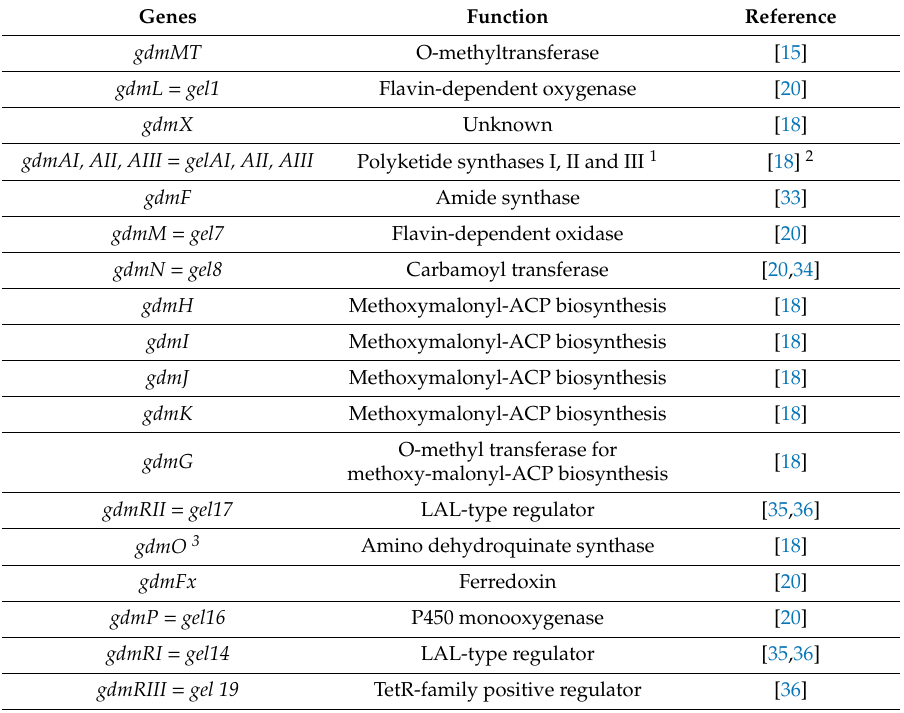
Figure 2. Cluster of geldanamycin genes in S. hygroscopicus NRRL3602. Cluster of geldanamycin genes in S. hygroscopicus NRRL3602 [18]. The name of each gene is indicated above it. Similar gene clusters have been found in other S. hygroscopicus strains and in S. autolyticus with the minor differences described in the text. Genes for the geldanamycin precursor AHBA [19], named gdnKEAOP, and located separately in the genome, are shown below. The names of the geldanamycin genes given by different authors and function of the encoded enzymes are shown in Table 2. Table 2. Genes in the geldanamycin cluster and function of the encoded enzymes.